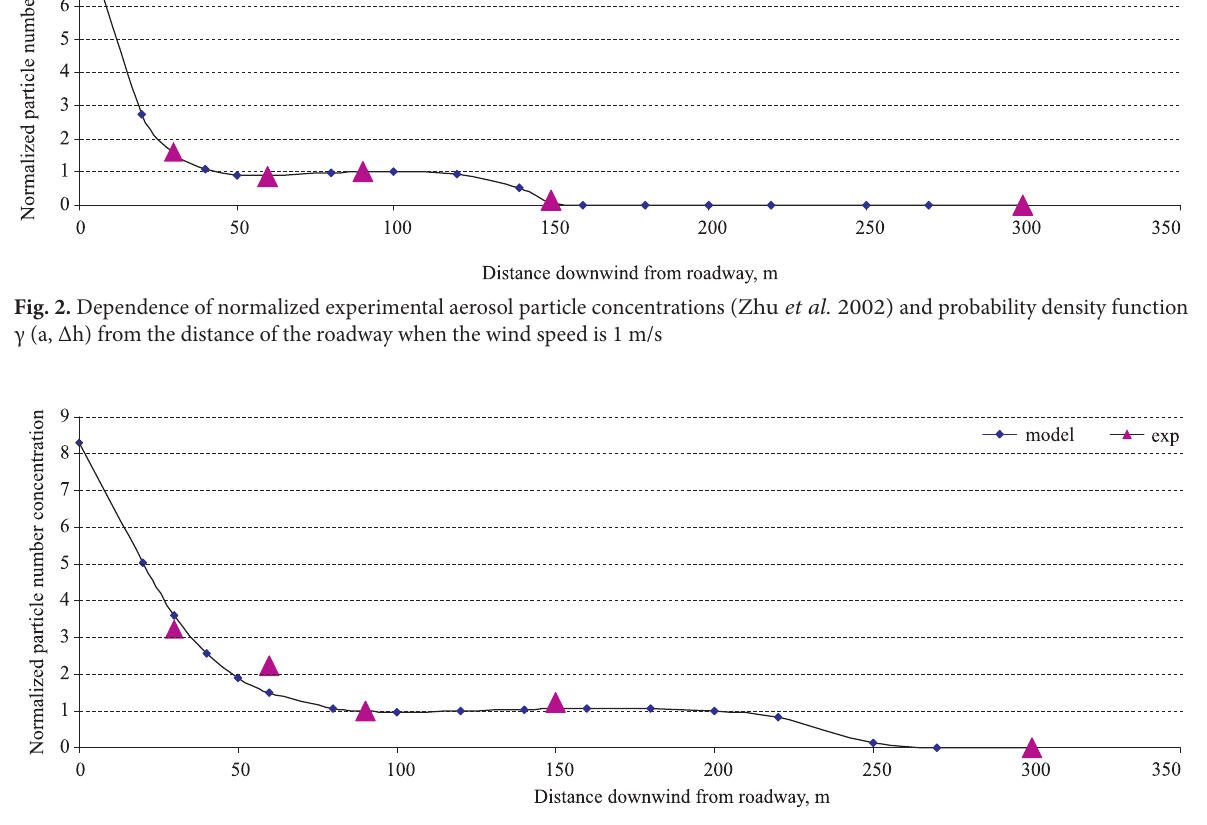
Fig. 3. Dependence of normalized experimental aerosol particle concentrations (Zhu et al. 2002) and probability density function γ (a, Δh) from the distance of the roadway when the wind speed is 2.5